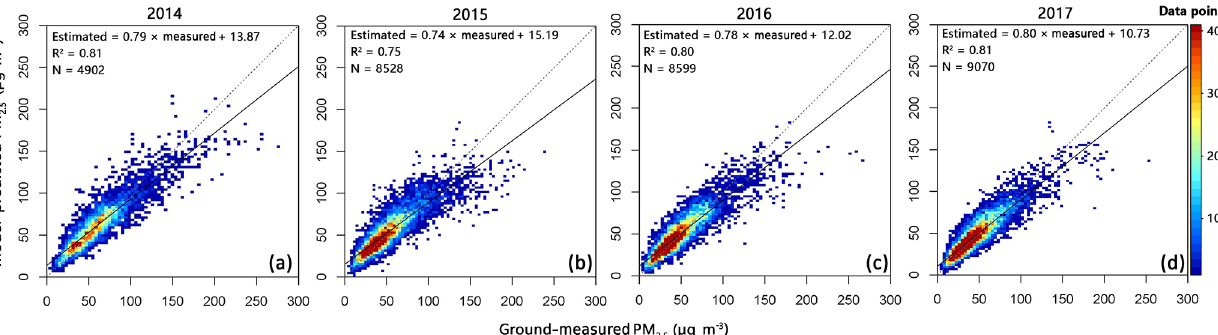
Figure 3. Validation of monthly mean PM 2 . 5 predictions from 2014 to